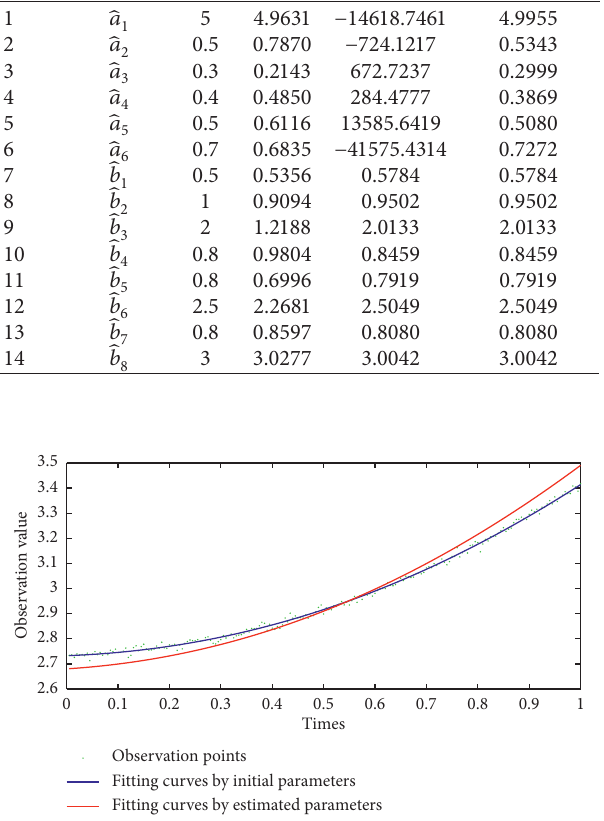
Figure 5: Observation points and fitting curves obtained using the three methods for Example 2.